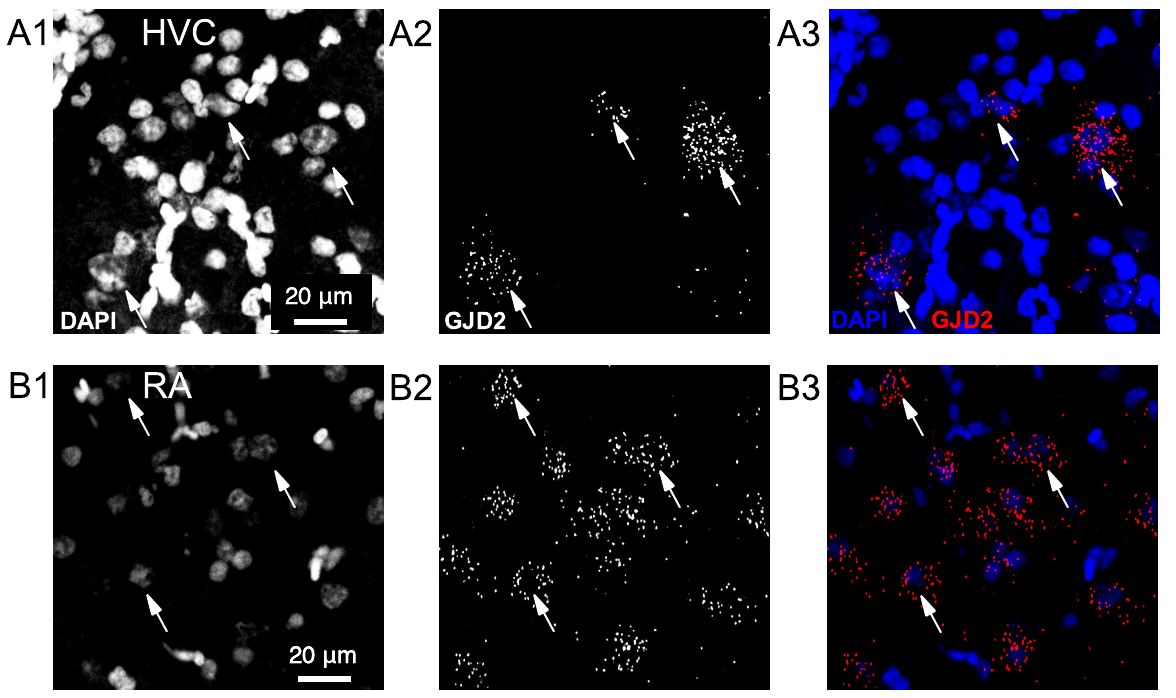
Figure 2. Expression of GJD2 mRNA in song nuclei HVC and RA from canaries. GJD2 mRNA labeling was counterstained by the nuclear staining, DAPI. ( A1 – A3 ) expression of GJD2 in a small fraction of cells in nucleus HVC. ( B1 – B3 ) widespread expression of GJD2 mRNA in nucleus RA. Single confocal planes. Arrows point toward three GJD2 mRNA-positive cells in each nucleus.